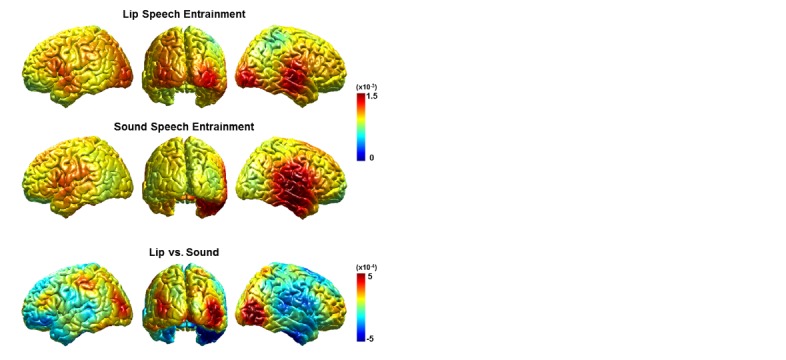
DOI:
http://dx.doi.org/10.7554/eLife.14521.013